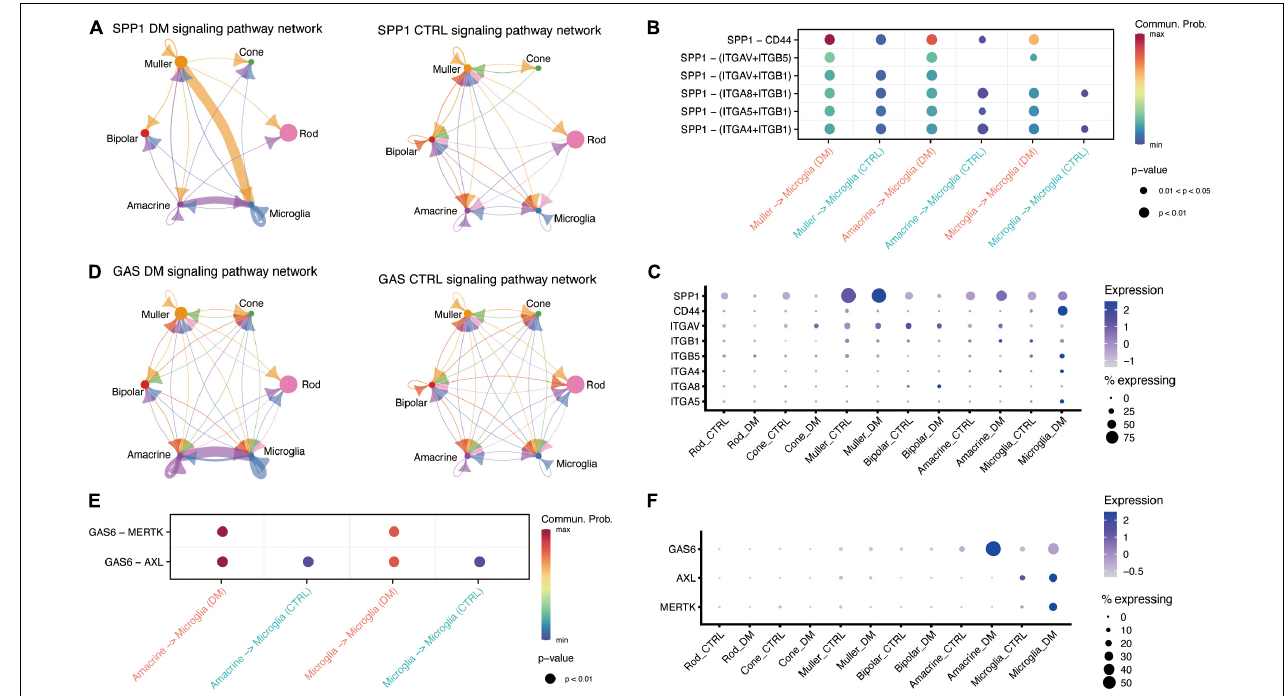
FIGURE 3 | Retinal cells communicate with microglia via SPP1 and GAS6 signaling pathway. (A) The inferred SPP1 signaling networks in the retina of DM (left) and control (right) monkeys. (B) Comparison of significant ligand-receptor pairs of SPP1 signaling pathway between DM and control retina. (C) Dotplot showing the expression of ligand SPP1 and its receptors, including CD44 , in DM and control retina. (D) The inferred GAS signaling networks between DM (left) and control (right) retina. (E) Comparison of significant ligand-receptor pairs of GAS signaling pathway between DM and control. (F) Dotplot showing the expression of ligand GAS6 and its receptors AXL and MERTK , in DM and control